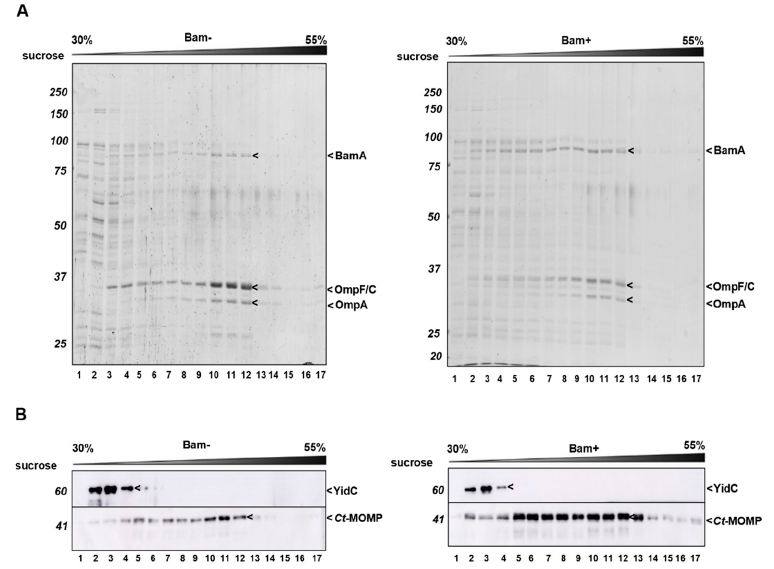
Figure 4. Ct -MOMP localized to the OM. Isopycnic sucrose gradient centrifugation of cell envelopes derived from E. coli co-expressing Ct -MOMP in the absence (-) or presence (+) of the Bam complex. Cell envelopes were derived from the high-speed pellets described in the legend in Figure 3. Fractions (1–17) collected from the top to bottom of each tube were analyzed by SDS-PAGE/Coomassie staining ( A ) or immunoblotting using antisera against Ct -MOMP or YidC as indicated ( B ).